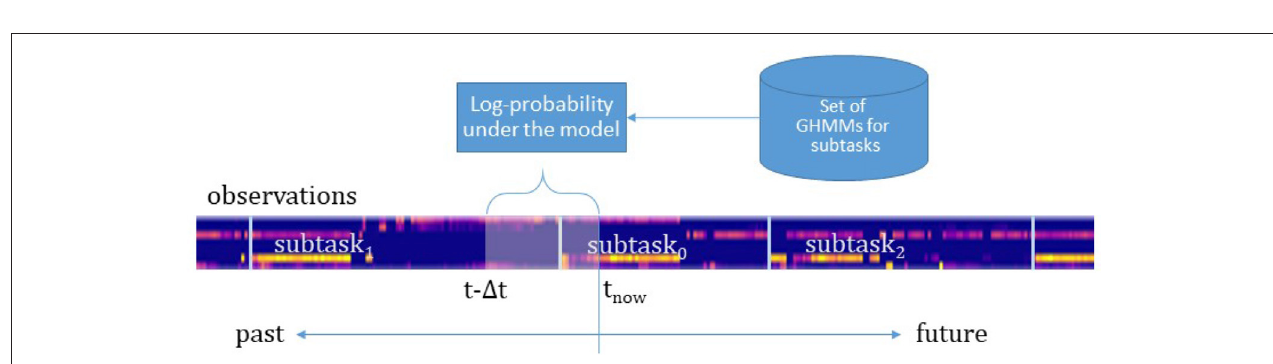
FIGURE 9 | The observations made in the last 1 t s are used to compute the log-probability of these observations under each of the trained GHMMs. Here, an example sequence of subtasks with the observations is shown. The feature vectors are color-coded, vertically plotted, and concatenated (generating the bluish bar). The length 1 t of the time window decides on the accuracy and the earliness of the intention